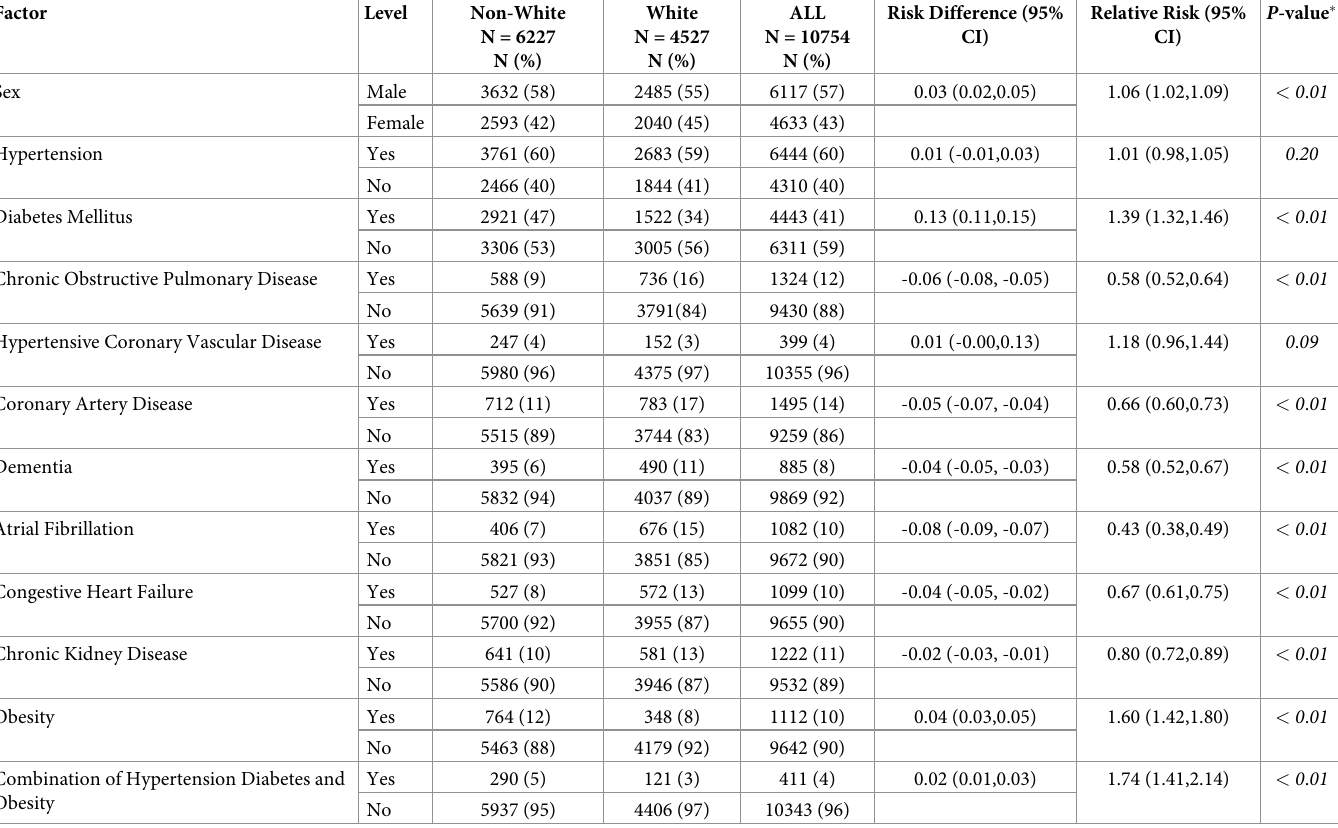
Table 2. Comparison of mortality and co-morbidities White Vs Non-White, Cook County,